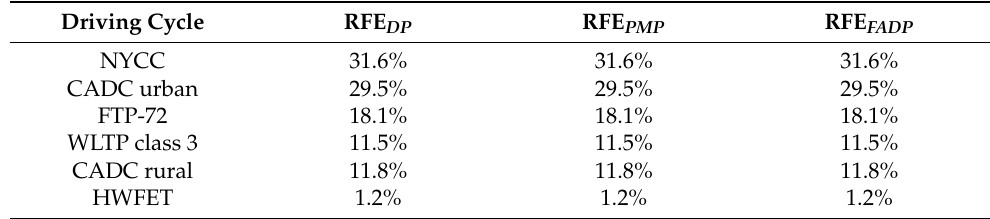
Table 4. Results of DP ( Q = M = 2000), PMP ( Q = 2000) and FADP ( M = 2000) applied to the driving cycles listed in Table 2 in terms of Relative Fuel Economy